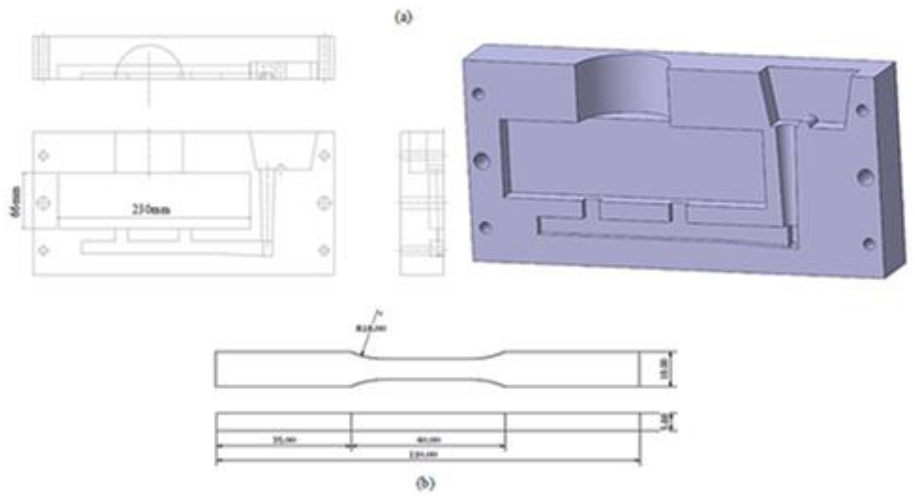
Fig. 1. Drawing presentation of (a) cast iron mould and (b) dimensions of tensile